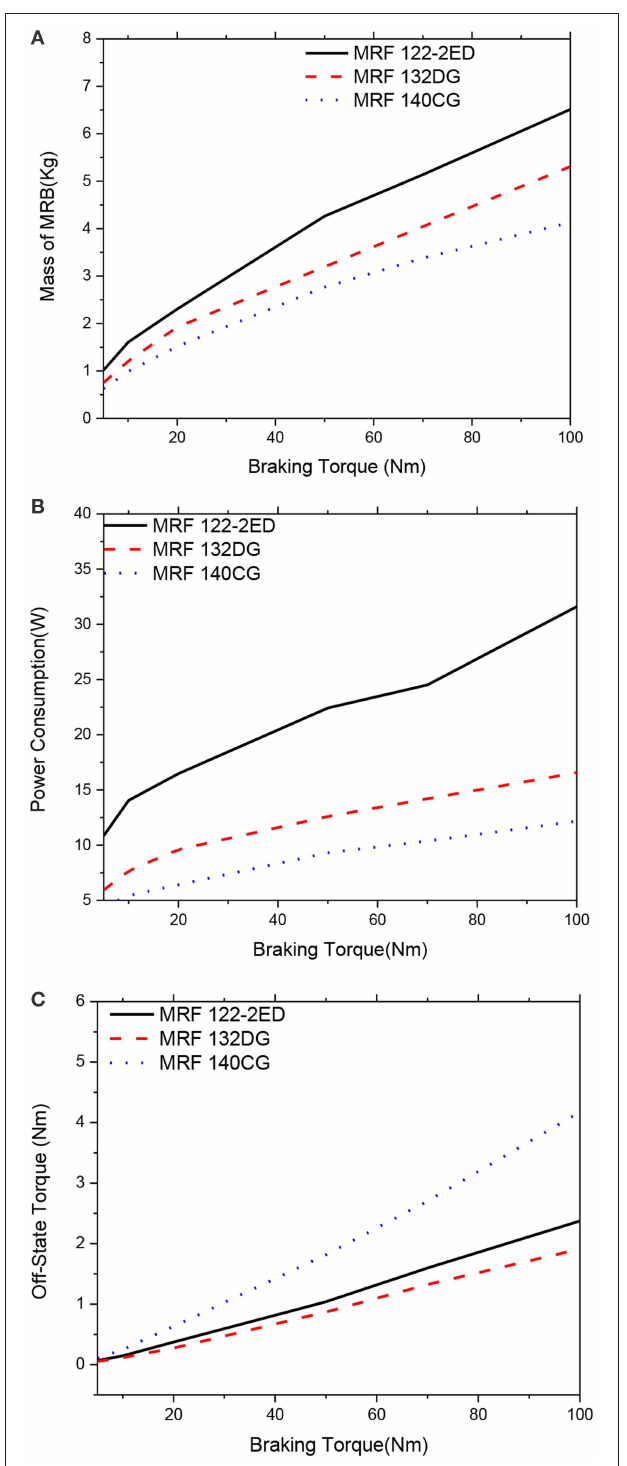
FIGURE 13 | Multi-objective optimization results of the MRBs as a function of braking torque of side-coil MRB, α m = α P = α To = 1/3. (A) Mass as a function of braking torque, (B) Power consumption as a function of braking torque, (C) Off-state torque as a function of braking torque.